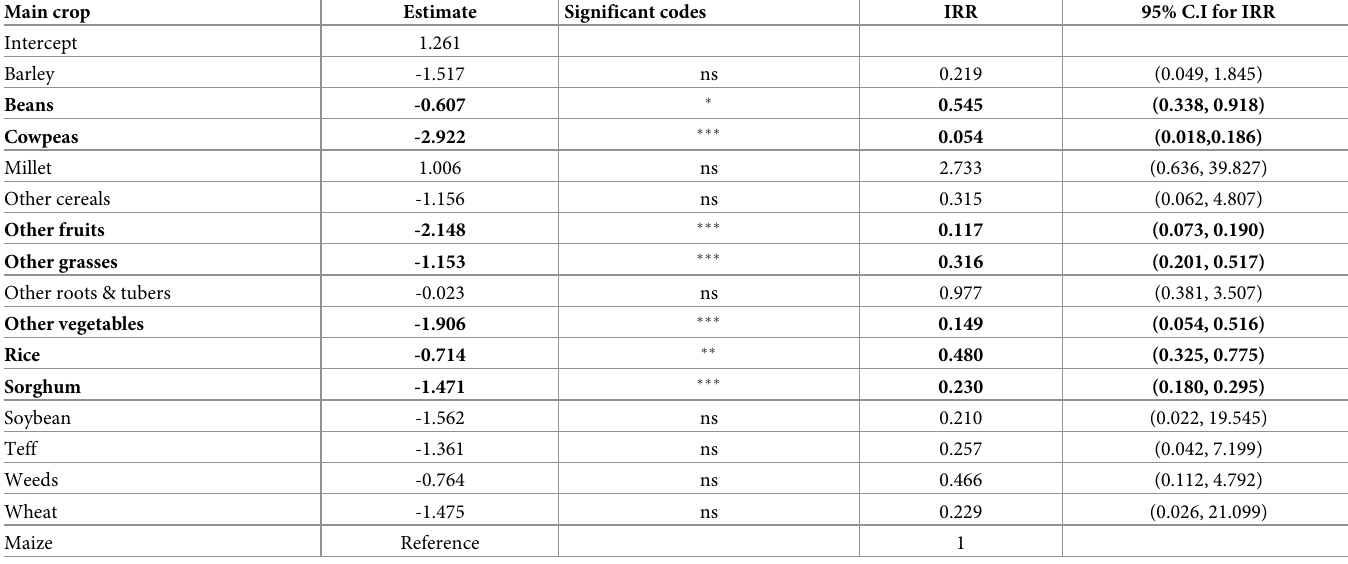
Table 1. Regression parameter estimates and incident rate ratios (IRR) estimated from the negative binomial model on trap counts for the main crop factor adjusted for crop phenology with main crop ‘Maize’ used as a reference level ϯ